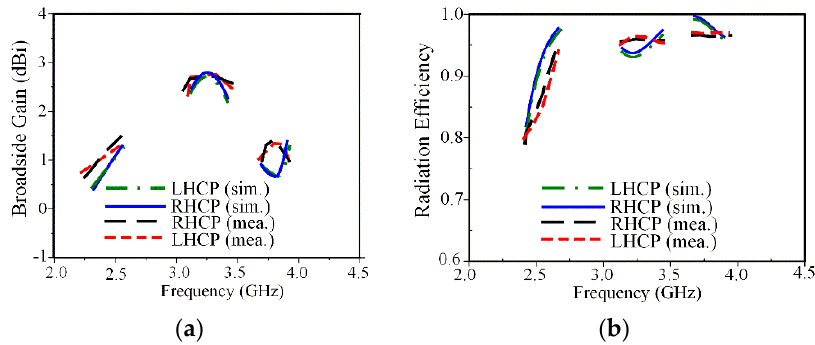
Figure 11. Measured results for both CP modes: ( a ) broadside gain; ( b ) radiation efficiency.